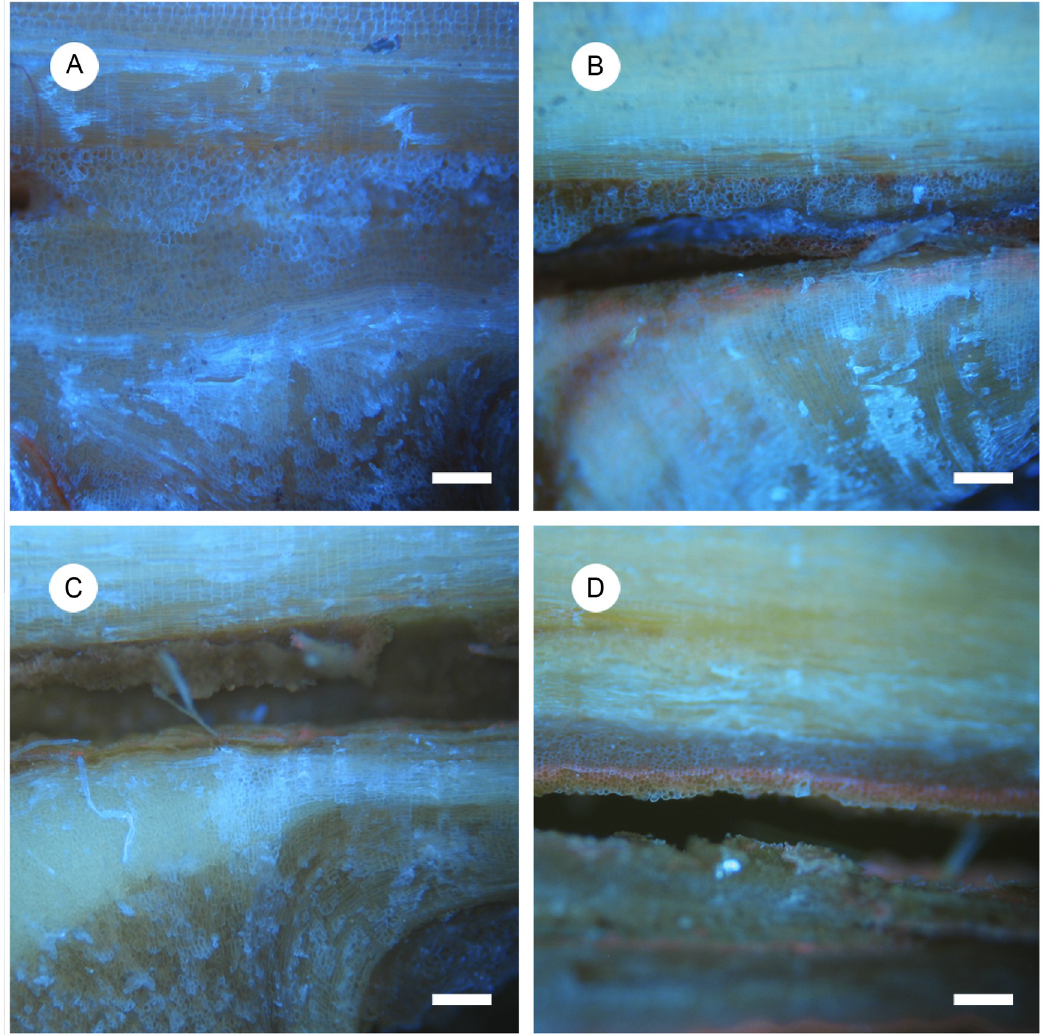
Fig 3. Cytomorphological patterns associated with graft incompatibility in the F 1 progeny grafted on the rootstock ‘Marianna 2624’ one month after grafting. Longitudinal sections were stained with calcofluor and phenotypic scores were based on cell proliferation, cell arrangement and cell shape at the graft interface. (A) Graft interface completely filled with ordered and round cells and new vascular connections established, (B) graft union partially filled with less defined and ordered cells, (C) groups of unordered and poorly defined cells at the graft interface and (D) Not cell proliferation at the graft